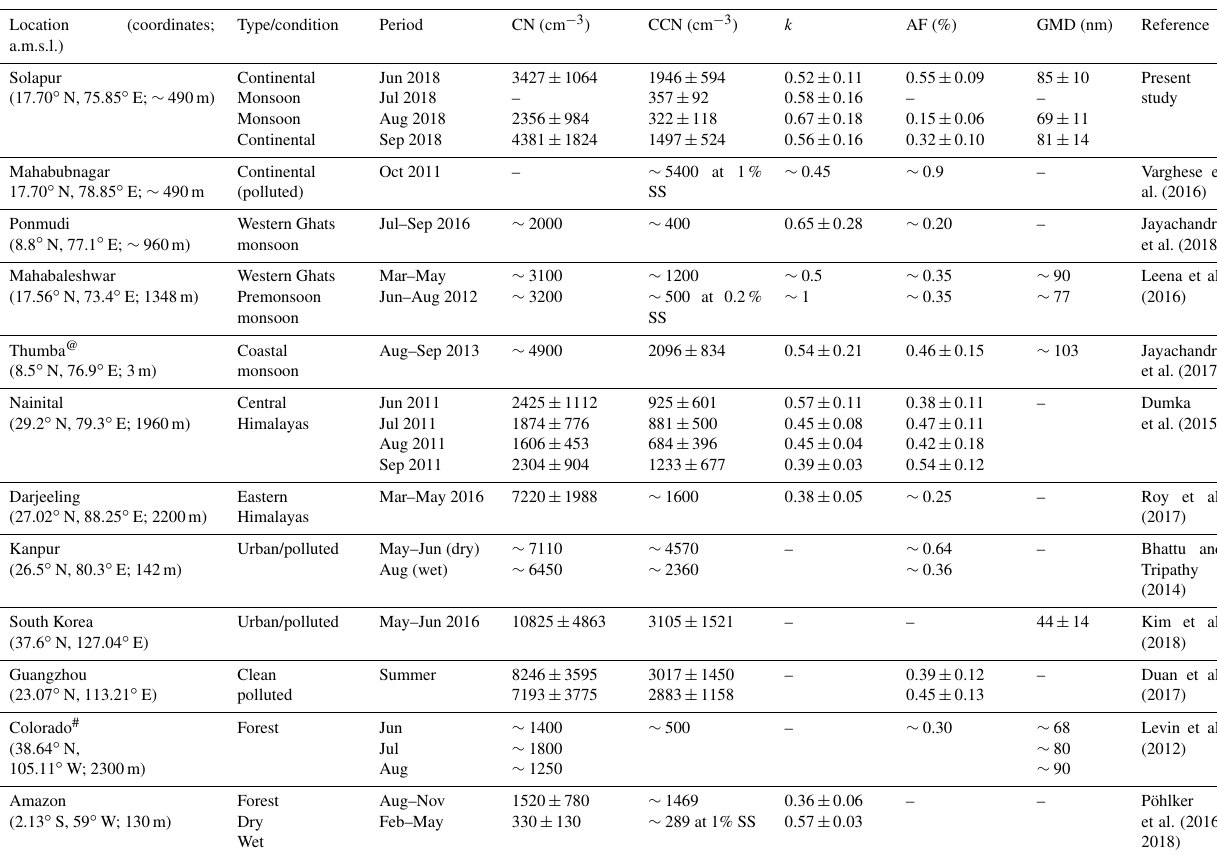
Table 2. CCN and aerosol characteristics reported over various locations along with the present results (at 0.3% SS). CCN reported for Thumba @ 0.4 and Colorado # 0.36% SS,